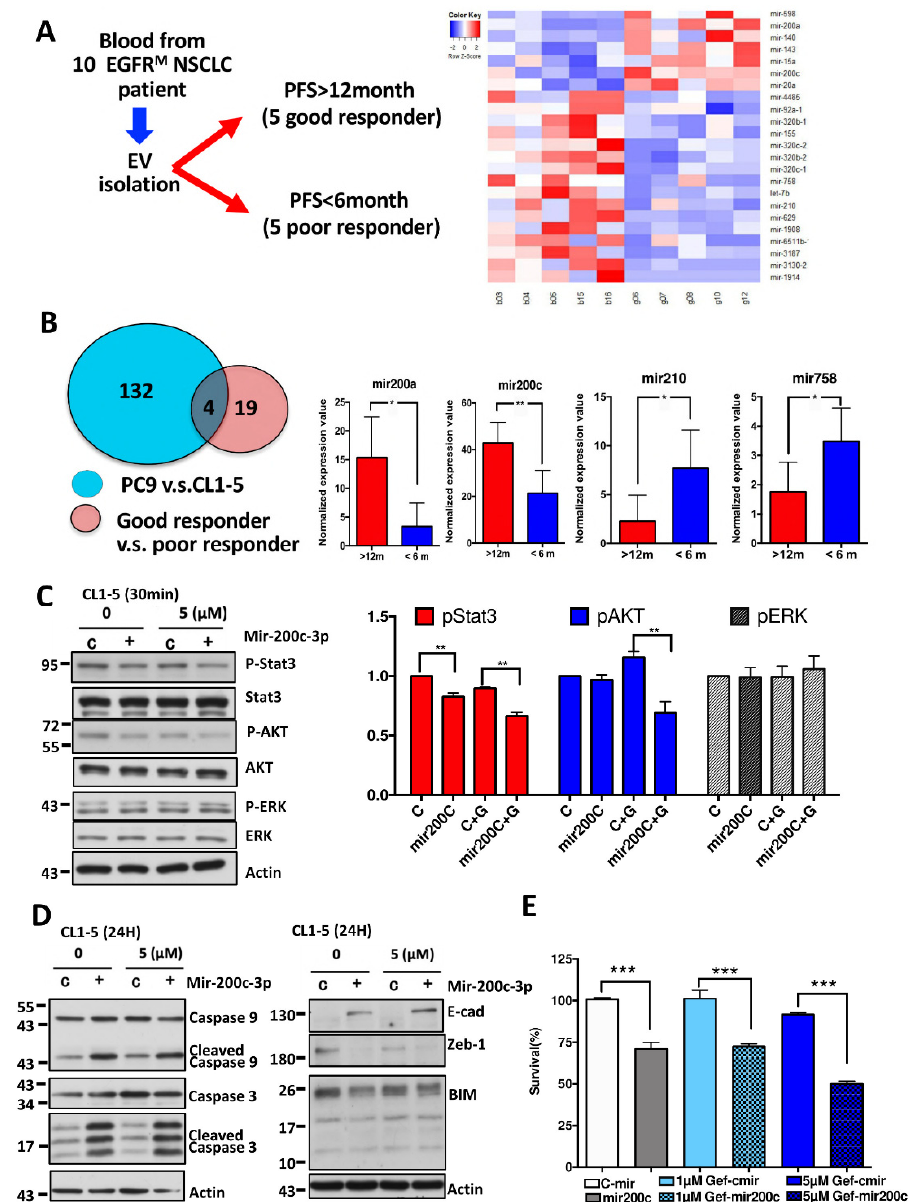
Figure 6. Differential miRNA expression from circulation EVs from patients with different responses to EGFR-TKI treatment corresponded to that from cell lines EVs. ( A ) Flowchart showing the collection of blood exosomal miRNAs from patients with different responses to EGFR-TKIs. Identification of differentially expressed miRNAs in responders and nonresponders to EGFR-TKIs. ( B ) Identification of miRNAs that are both differentially expressed between responders and nonresponders to EGFR-TKIs and between EVs from PC9 cells and CL1-5 cells. ( C ) CL1-5 cells were transfected with miR-200c and treated with gefitinib, and the pStat3, Stat3, pAkt, Akt, pErk, and Erk protein levels were detected with a Western blot kit. ( D ) The changes in apoptosis-related proteins, including caspase-3 and caspase-9, after miR-200c transfection with gefitinib treatment were determined using Western blotting. The combination of miR-200c and treatment with gefitinib affected EMT-related proteins (E-cadherin and Zeb1) and BIM protein. ( E ) Histograms showing the enhanced efficacy of gefitinib in CL1-5 cells transiently transfected with miR-200c as determined by MTT assays (* p < 0.05, ** p < 0.01, *** p < 0.005).